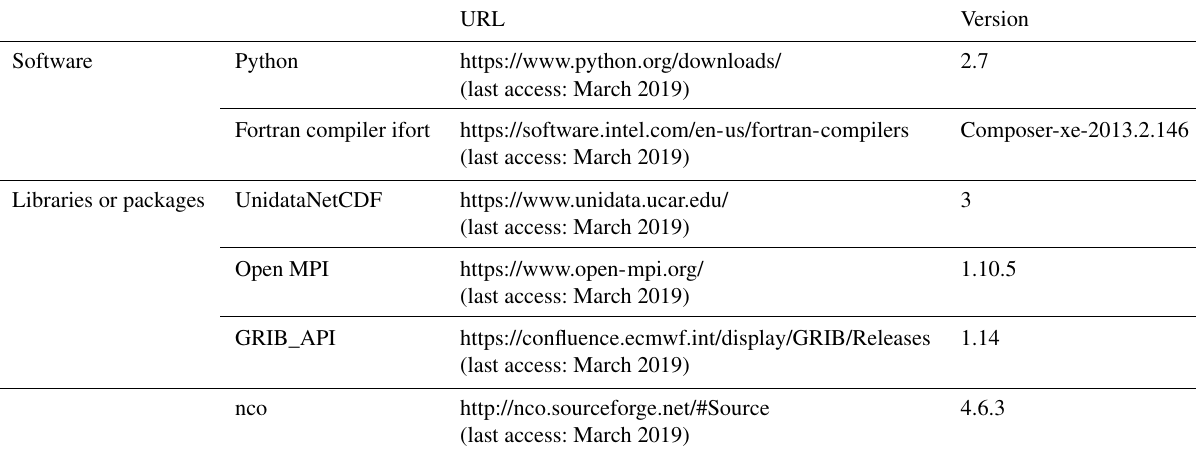
Table 2. URL addresses for the development and the use of the PYVAR-CHIMERE system and its modules.